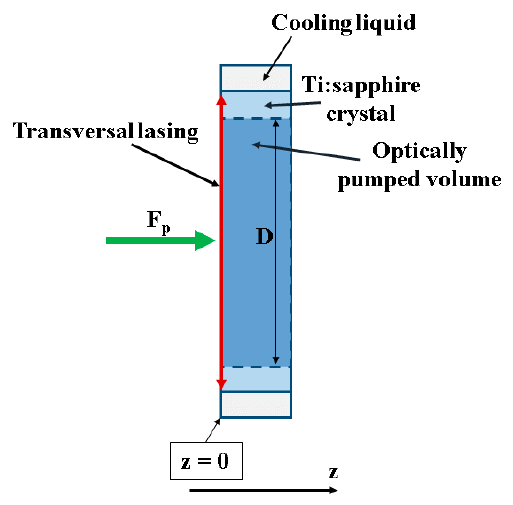
Figure 11. Transversal lasing near the pumped end-face of the Ti:sapphire crystal.